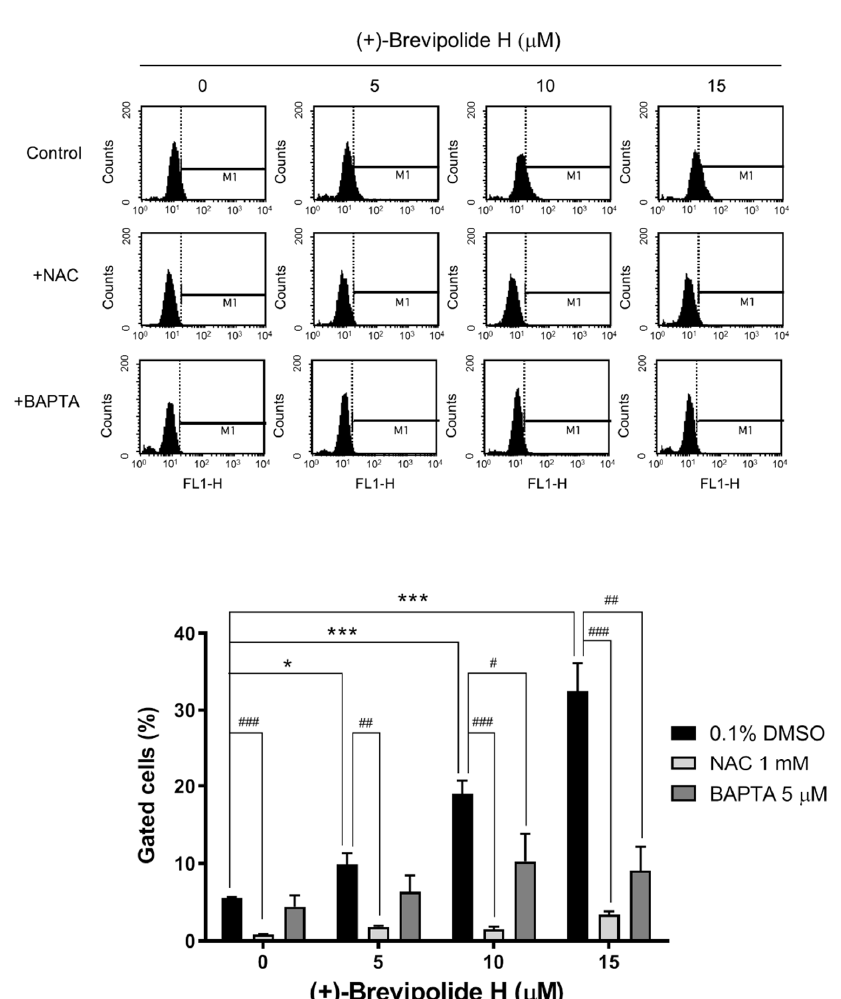
Figure 5. Effect of (+)-brevipolide H on ROS production in PC-3 cells. The cells were treated in the Figure 5. E ff ect of ( + )-brevipolide H on ROS production in PC-3 cells. The cells were treated in the absence or presence of (+)-brevipolide H (5 to 15 µM), NAC (1 mM), and BAPTA (5 µM) for 1 h. ROS absence or presence of ( + )-brevipolide H (5 to 15 µ M), NAC (1 mM), and BAPTA (5 µ M) for 1